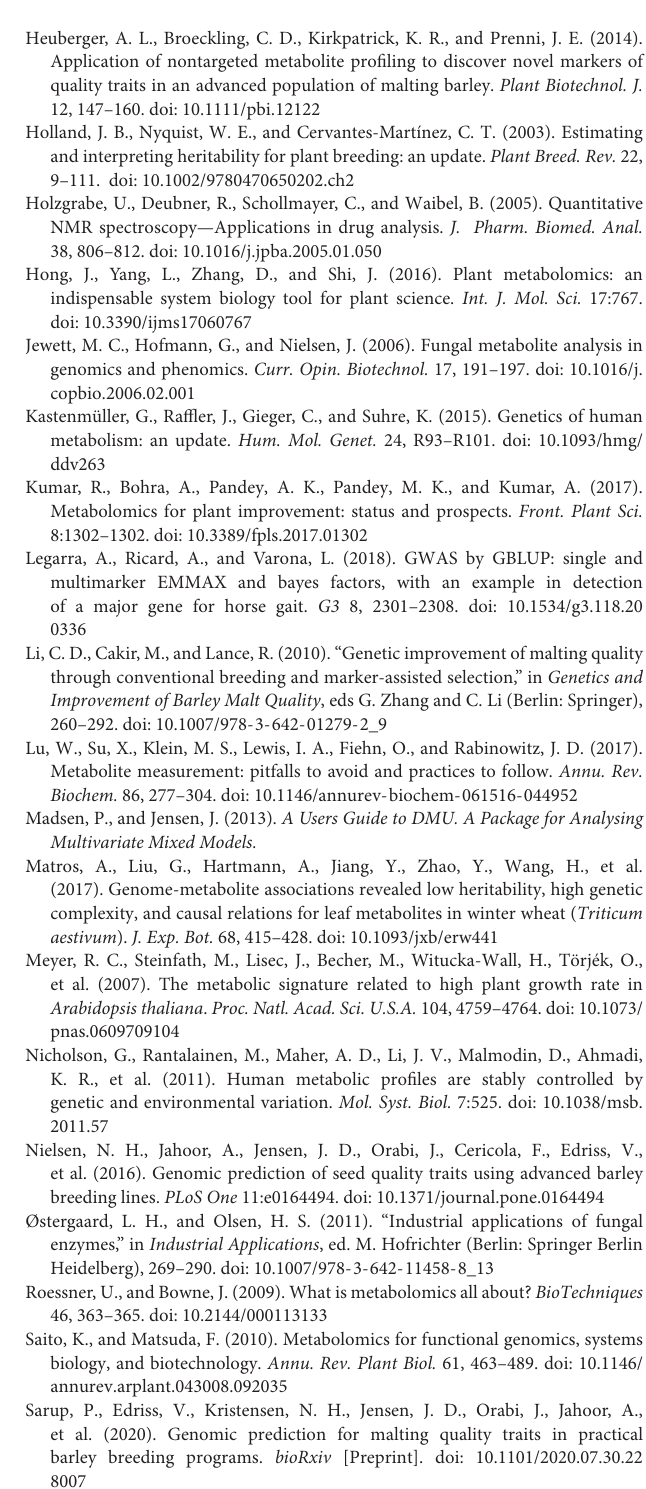
Supplementary Table S5 | Descriptive statistics for phenotypic correlations between 8,604 significantly heritable metabolomic features and malting quality